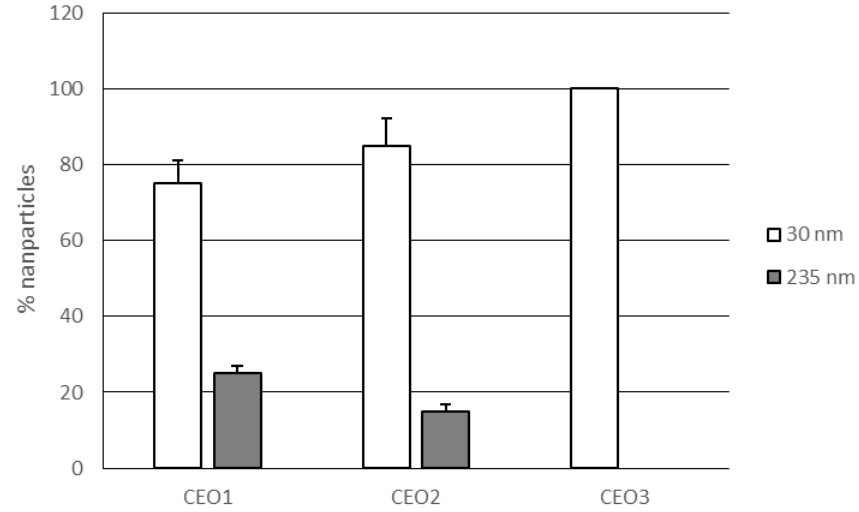
Figure 2. Percentages of nanoparticles with different mean size (30 and 235 nm) in lipid nanoparticles CEO1–3.